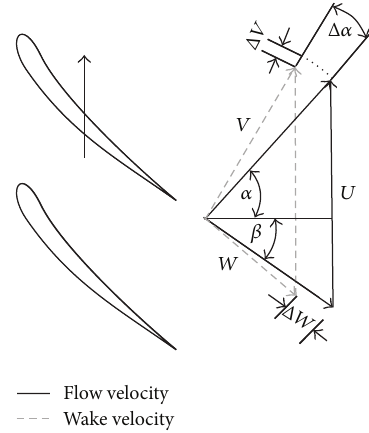
Figure 6: Rotor exit velocity triangle including rotor wake.